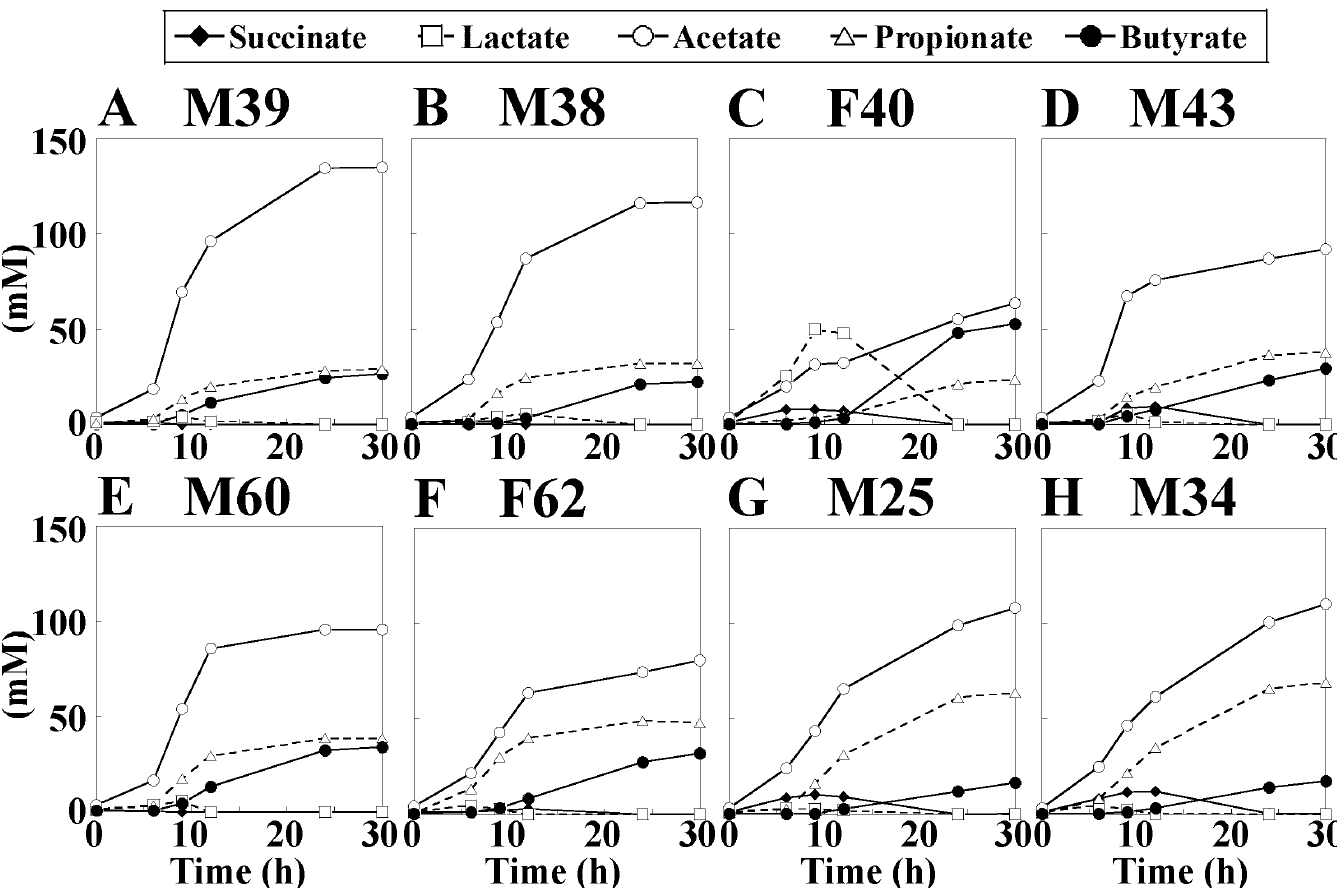
Fig 5. Time-dependent changesof short-chain fatty acid (SCFA) concentrations in the KUHIMM cultures inoculated with one of each of the humanfecal samples (A: M39, B: M38, C: F40, D: M43, E: M60, F: F62, G: M25, H: M34).